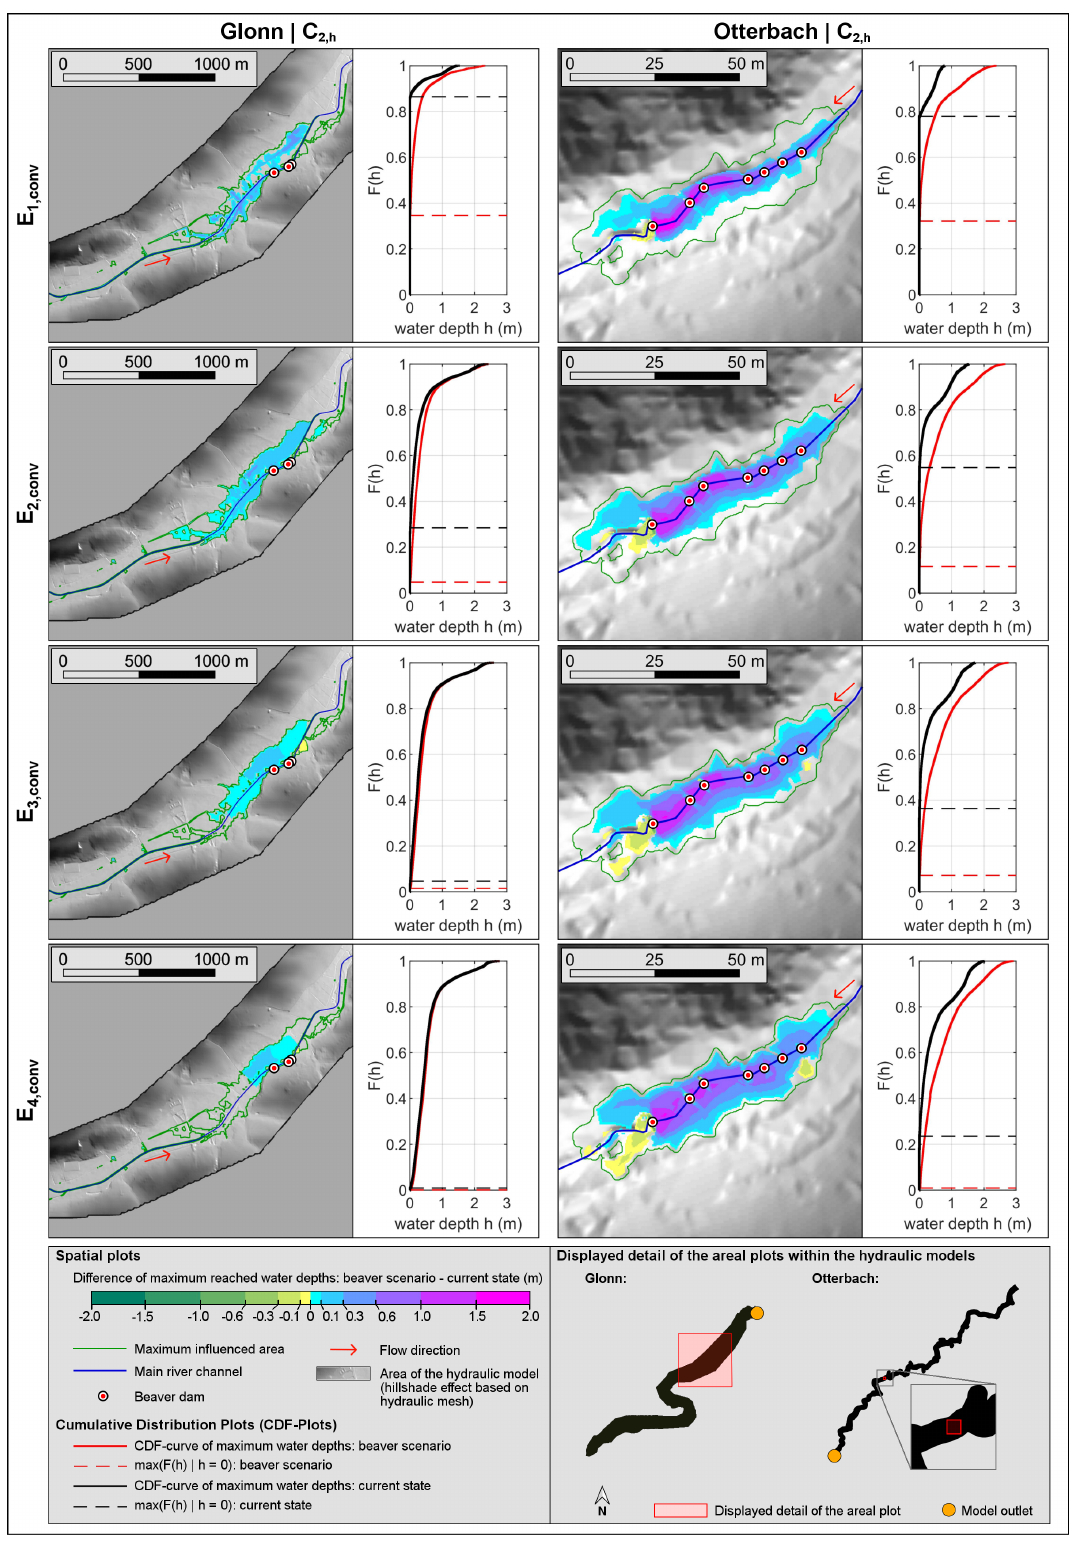
Figure 9. Spatial plots of the differences in the maximum water depths between the beaver dam scenario C 2, h and the current state model in the Glonn ( left ) and the Otterbach ( right ) catchment. Additionally, the cumulative distribution functions of the maximum water depths in the respective influenced areas are